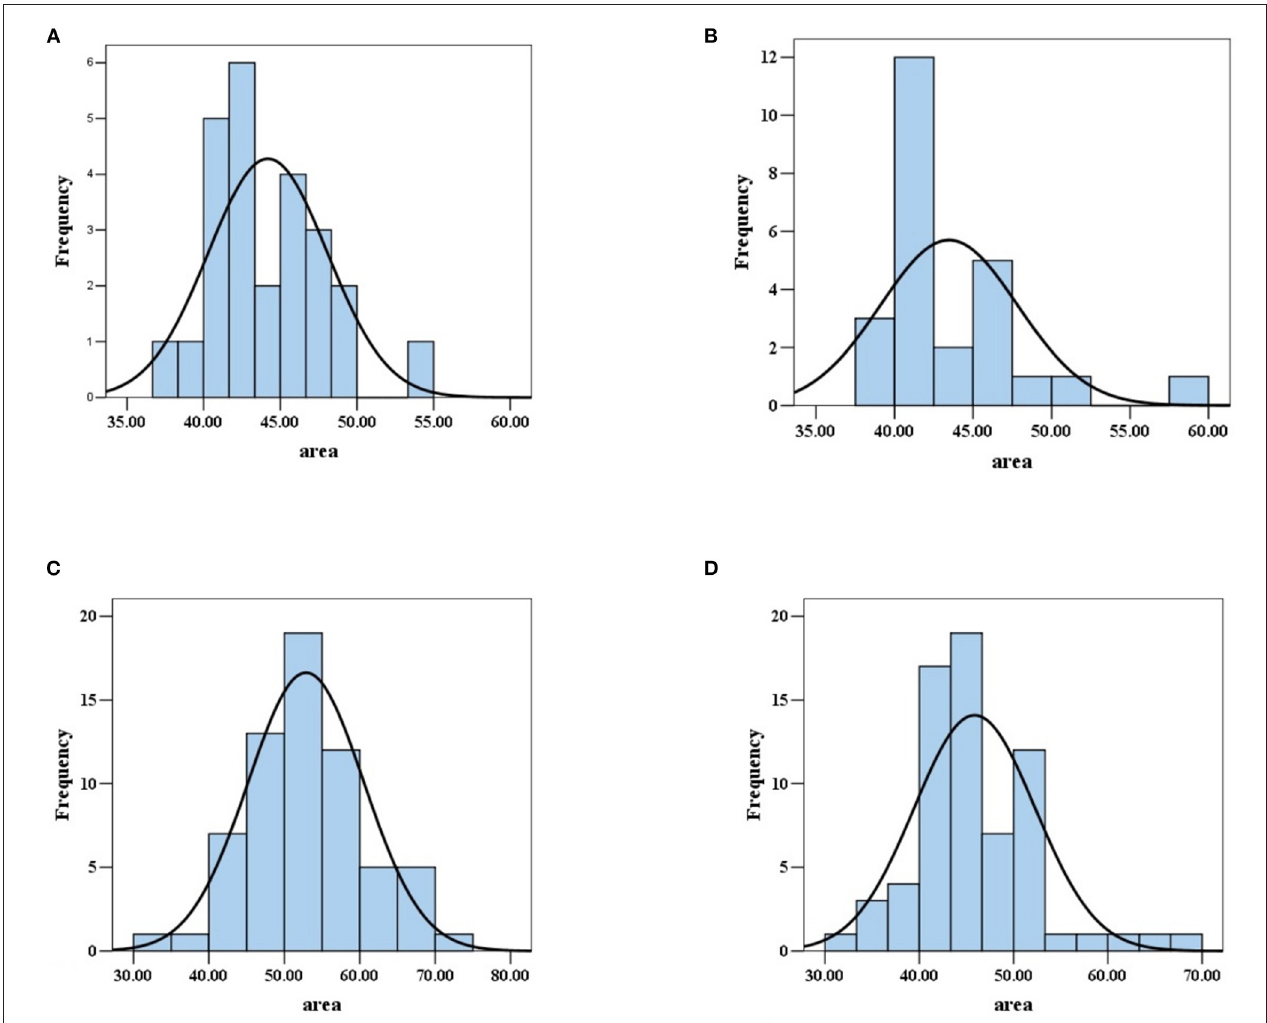
FIGURE 3 | Area values distribution of red blood cells in normal subjects and patients with AA, MA, and MDS. (A) The area values of red blood cells in normal subjects satisfied normal distribution. (B) The area values of red blood cells in patients with AA did not satisfy normal distribution. (C) The area values of red blood cells in patients with MA satisfied normal distribution. (D) The area values of red blood cells in MDS patients did not satisfy normal distribution.